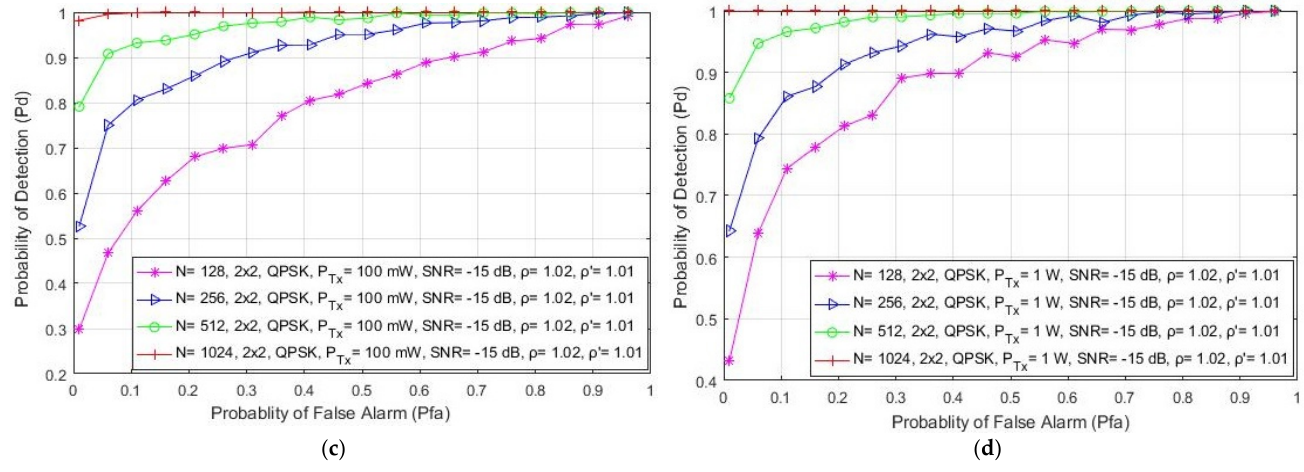
Figure 5. The ROC curves presenting the ED performance for the different number of samples in ( a ) the SISO system with a PU Tx power of 100 mW, ( b ) the SISO system with a PU Tx power of 1 W, ( c ) the MIMO 2 × 2 system with a PU Tx power of 100 mW and ( d ) the MIMO 2 × 2 system with a PU Tx power of 1 W.